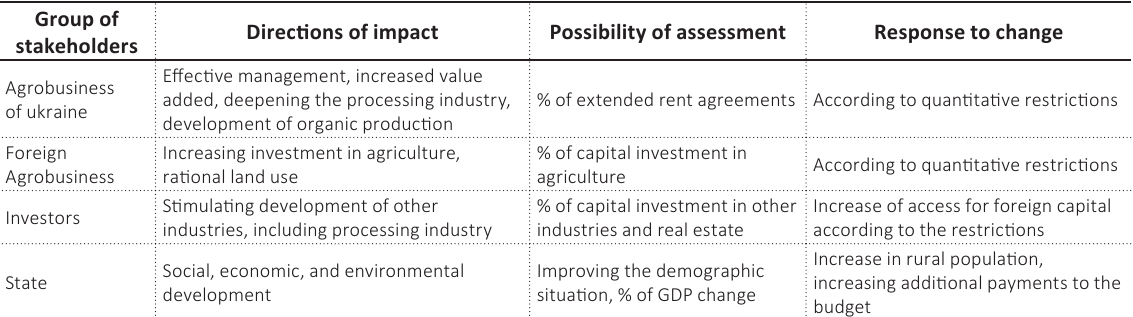
Table 2. Consequences of the updated land reform implementation Group